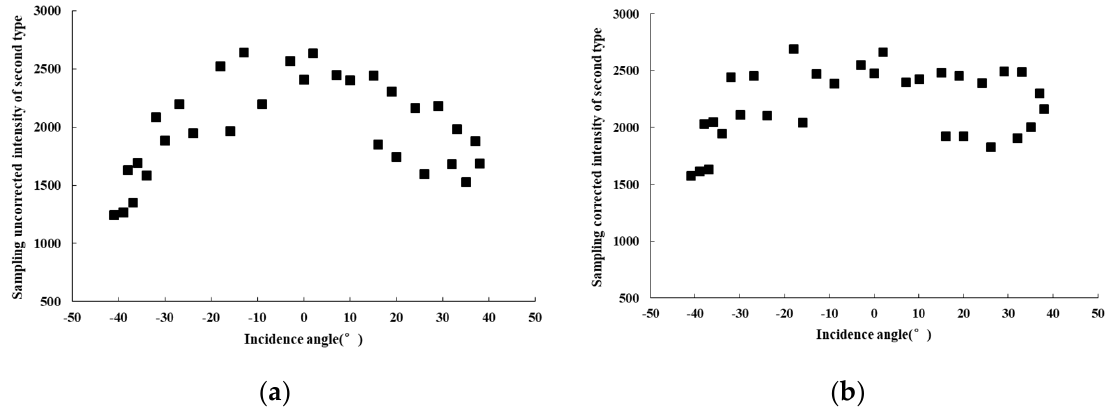
Figure 8. Results for strip 1: ( a ) the original intensity values (the amplitude); ( b ) the corrected intensity values by elimi- nating the effects of incident angle and range.